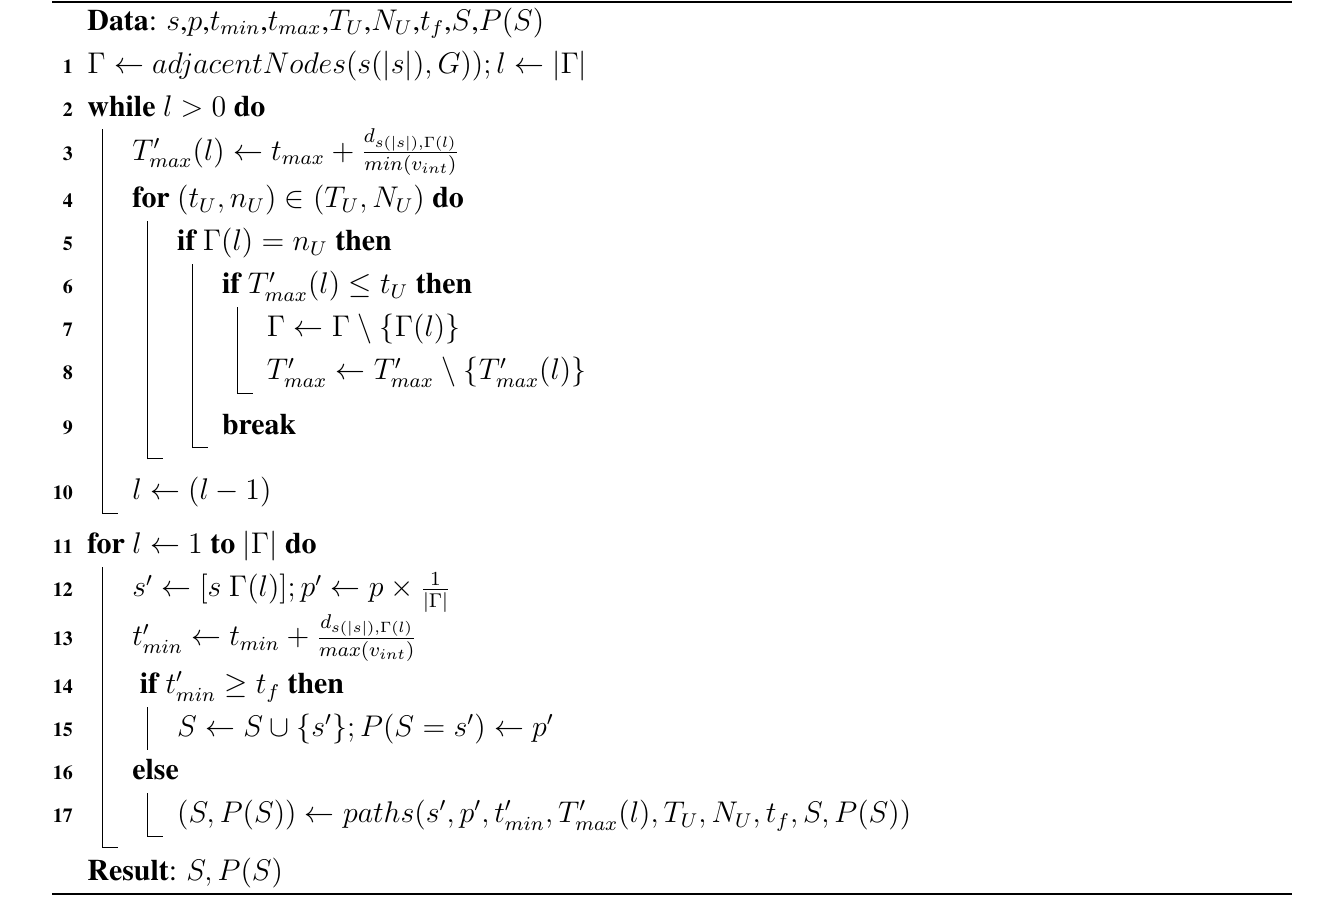
Algorithm 2: The paths()algorithm to find possible intruder